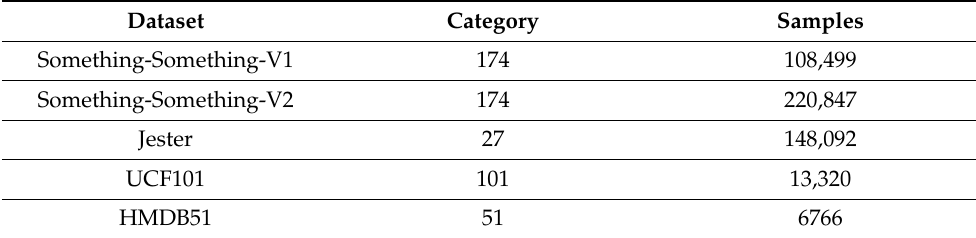
Table 1. Public datasets of human action recognition.